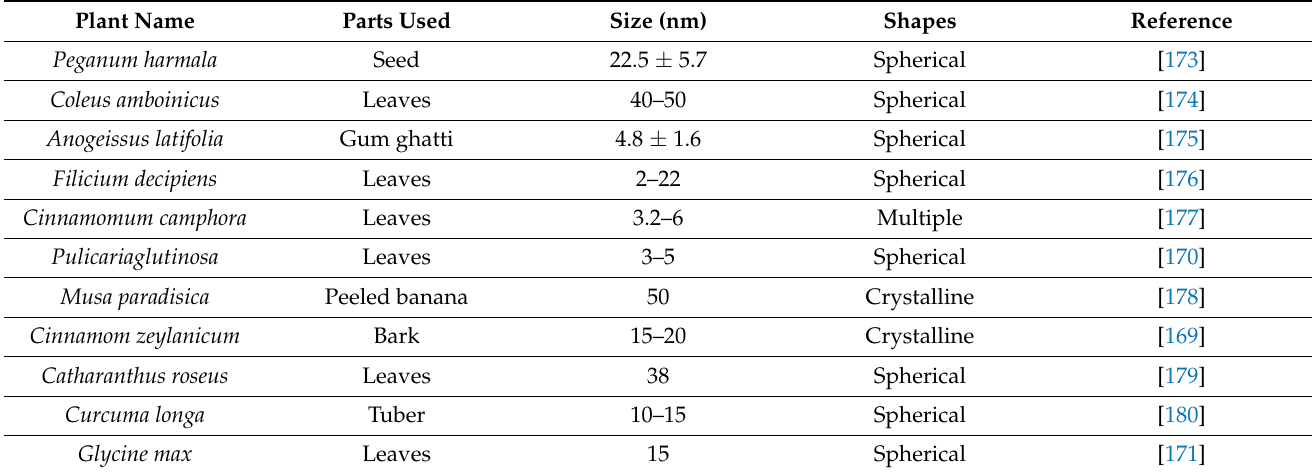
Table 5. Plant-assisted synthesis of palladium